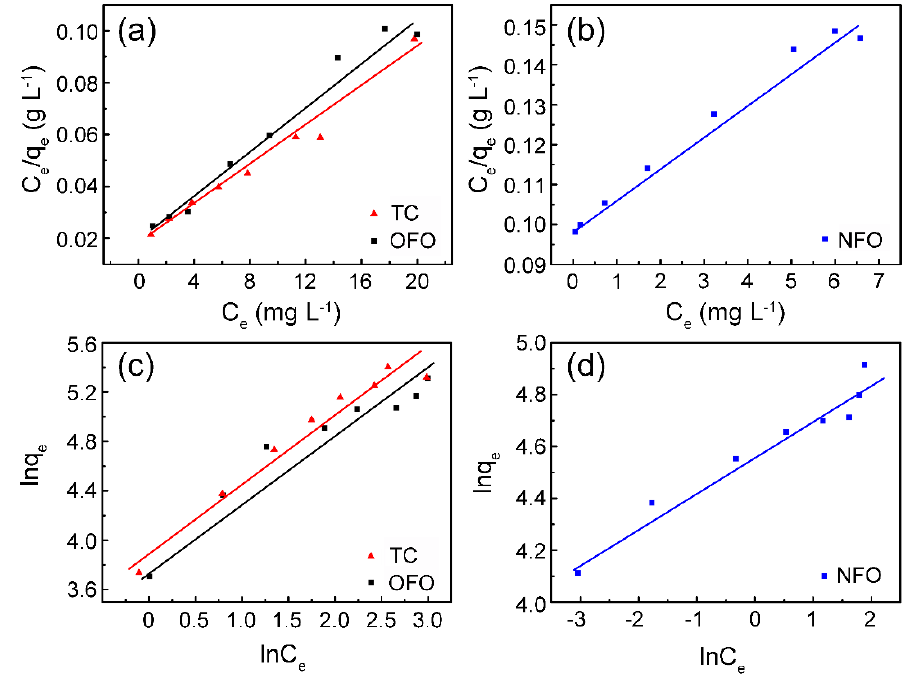
Figure 4. The isothermal adsorption fitting curves of Langmuir ( a , b ) and Freundlich ( c , d ) for tetracycline (TC), levofloxacin (OFO), and norfloxacin (NFO) by ZHC. Table 1. The relevant fitting parameters of tetracycline (TC), norfloxacin (NFO), and levofloxacin (OFO) simulated using Langmuir and Freundlich models.